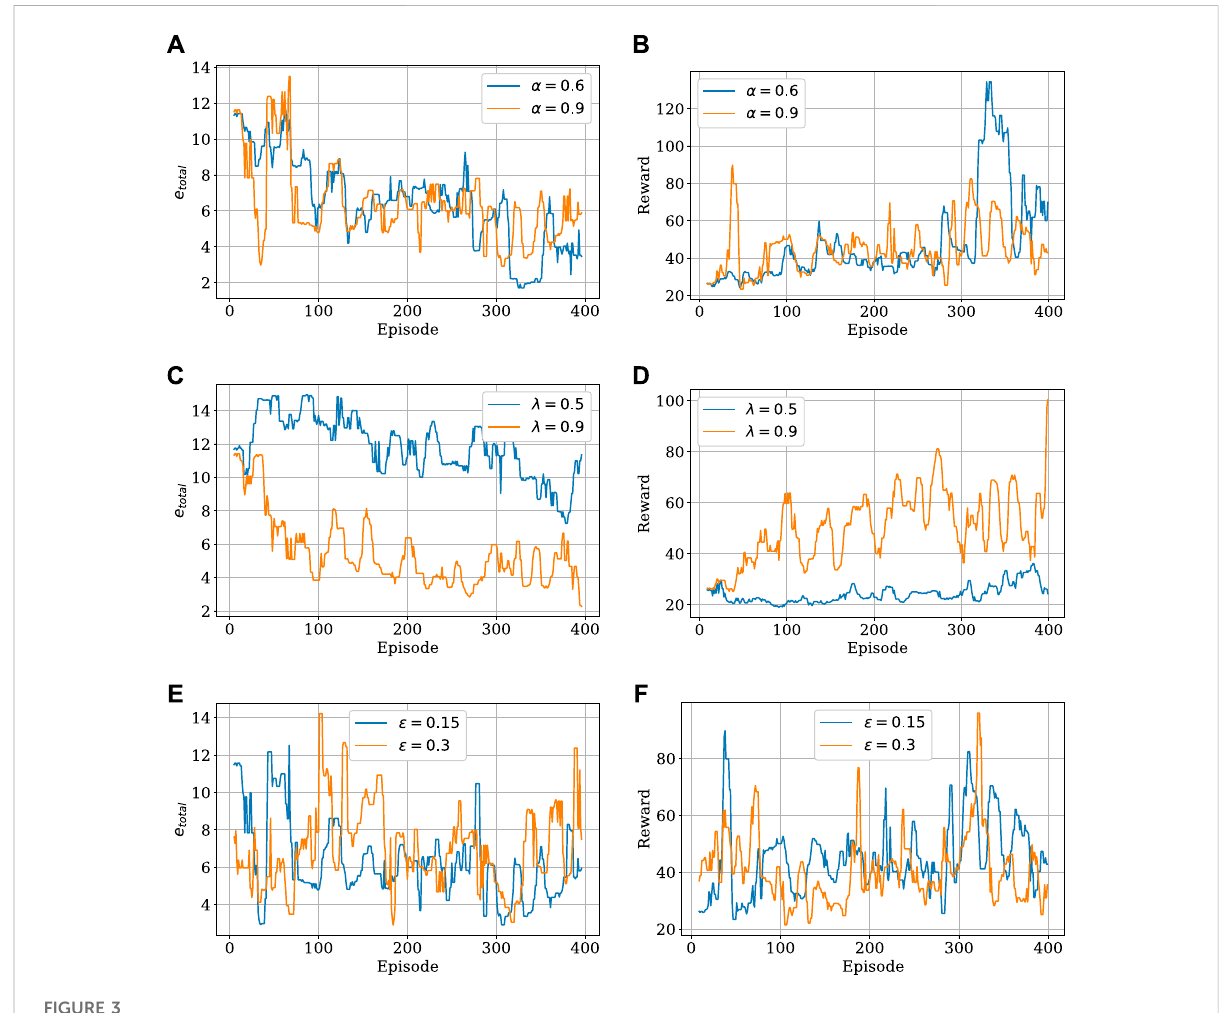
FIGURE 3 Simulation results of the proposed learning framework with the variation of step size α (A , B) , trace decay rate λ (C , D) , and ϵ -greedy parameter (E , F) with respect to the total number of steps per episode and returns per